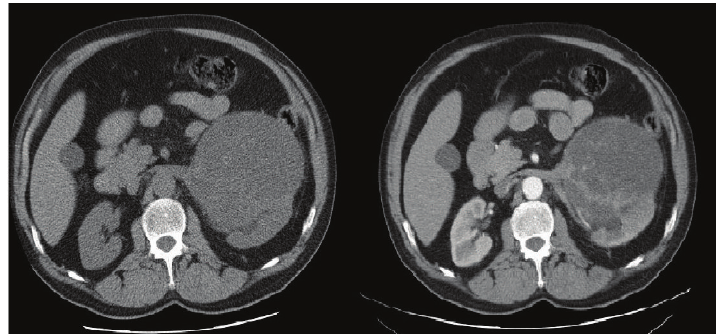
Figure 1: The view of the cystic, thick-walled, septated, and vascularized mass at the arterial phase of the computed tomography.